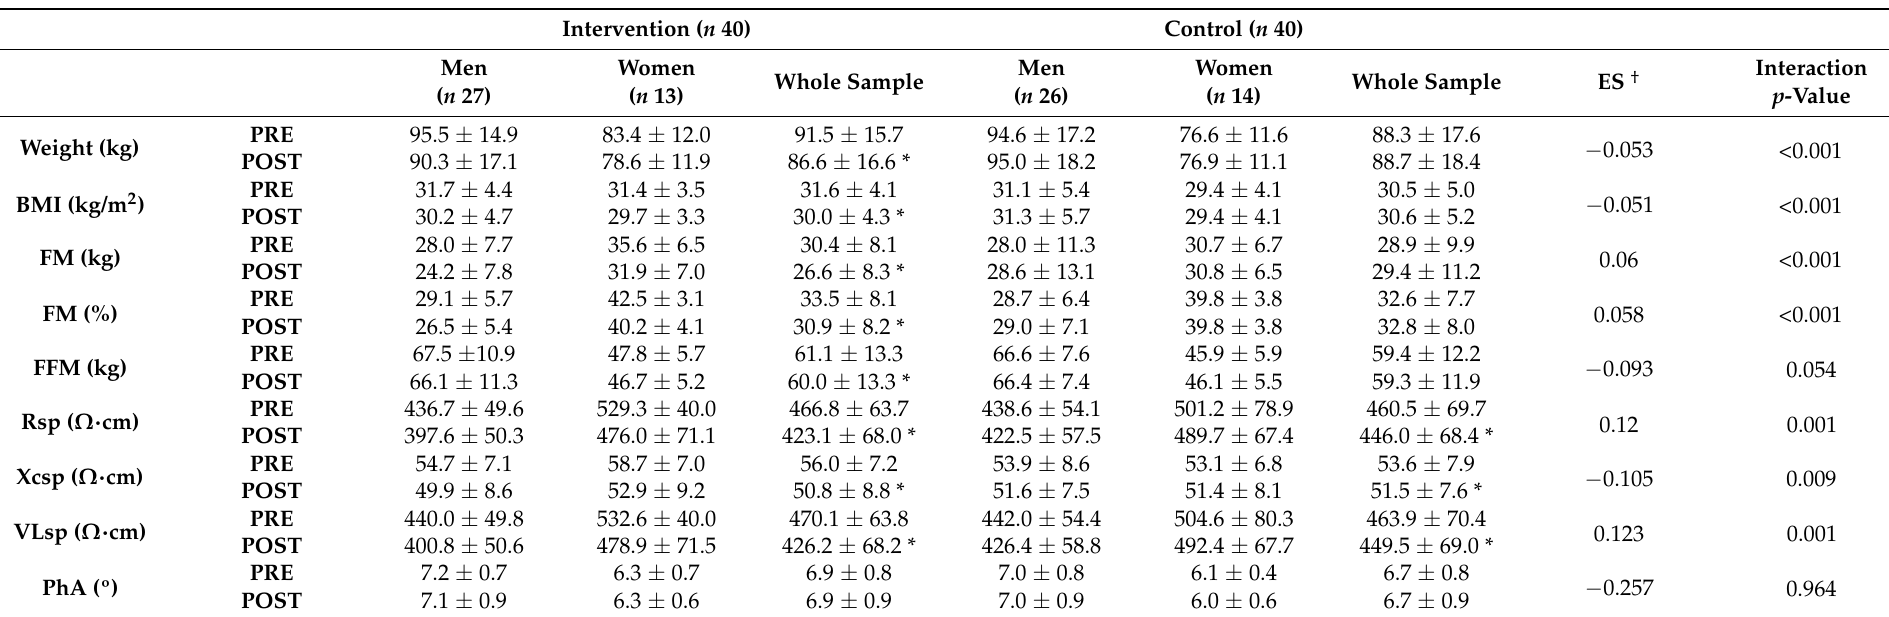
Table 1. Linear mixed models for the comparisons between the groups at baseline (PRE) and after 16 weeks